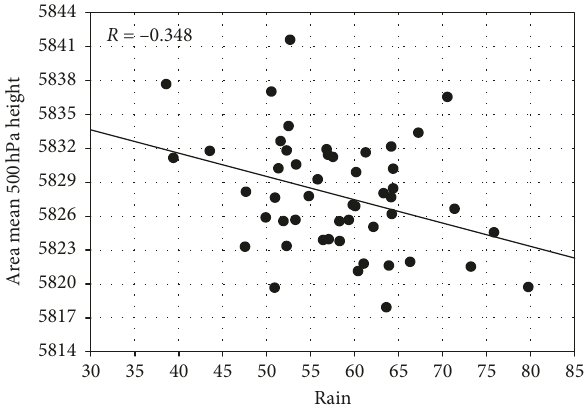
Figure 10: Scatter plot (black plots) of area-averaged 500 hPa GPH over SCB ( y -coordinate) with precipitation over SCB ( x - coordinate) in the 50 ensemble members on 18 July (forecast for next 90–108 h, 4-time average). The linear least squares fitting line is also shown. The linear correlation coefficient is given in the top